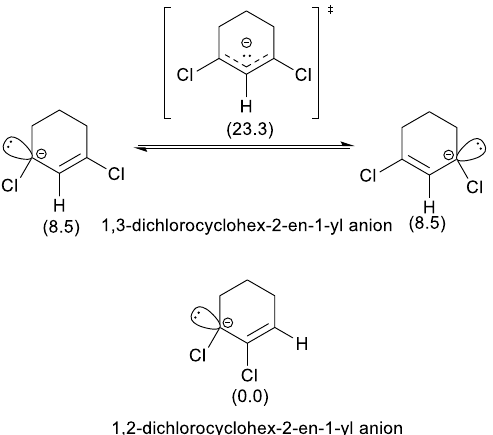
Figure 3. 1,3- and 1,2-Dichlorocyclohex-2-en-1-yl carbanions. Calculated relative Gibbs free energies (kJ mol −1 ) are shown in